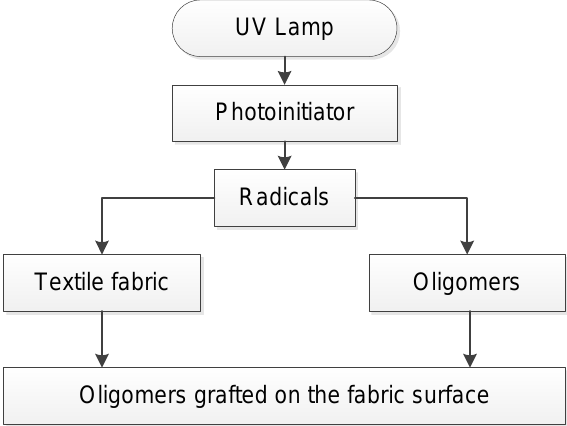
Figure 2. UV grafting process on fabric.